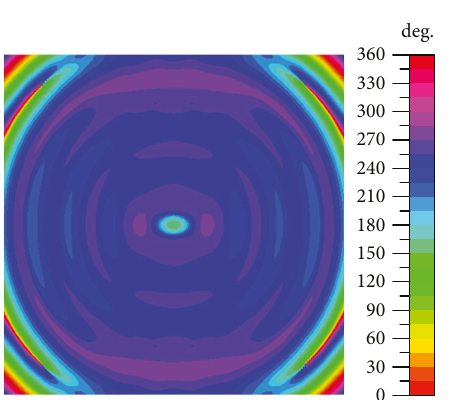
Figure 14: Simulated scattered fi eld copolar phase distribution plot at z =45mm plane (behind the